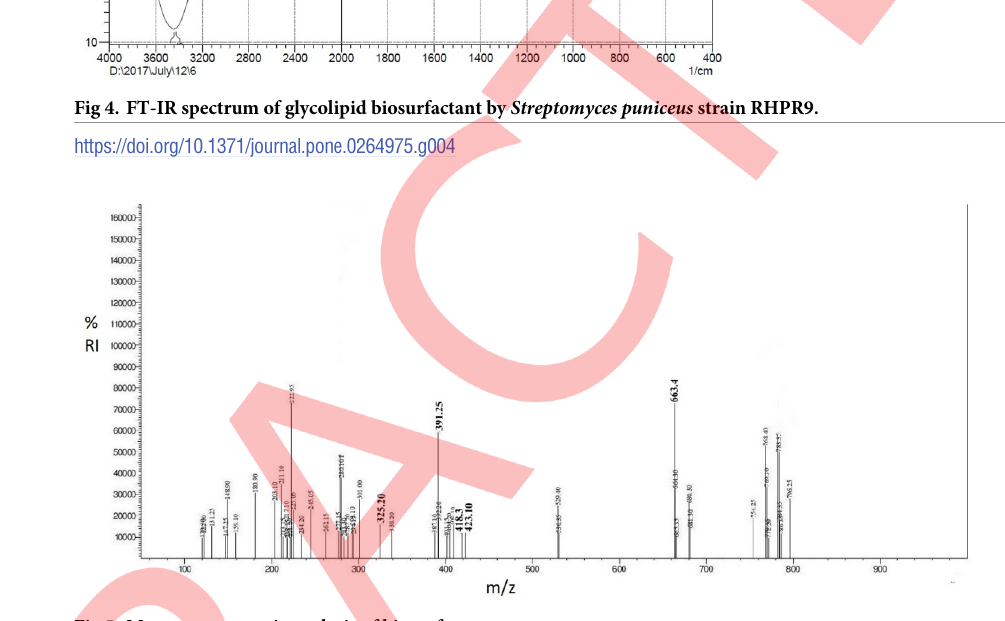
Fig 5. Mass spectrometric analysis of biosurfactant.